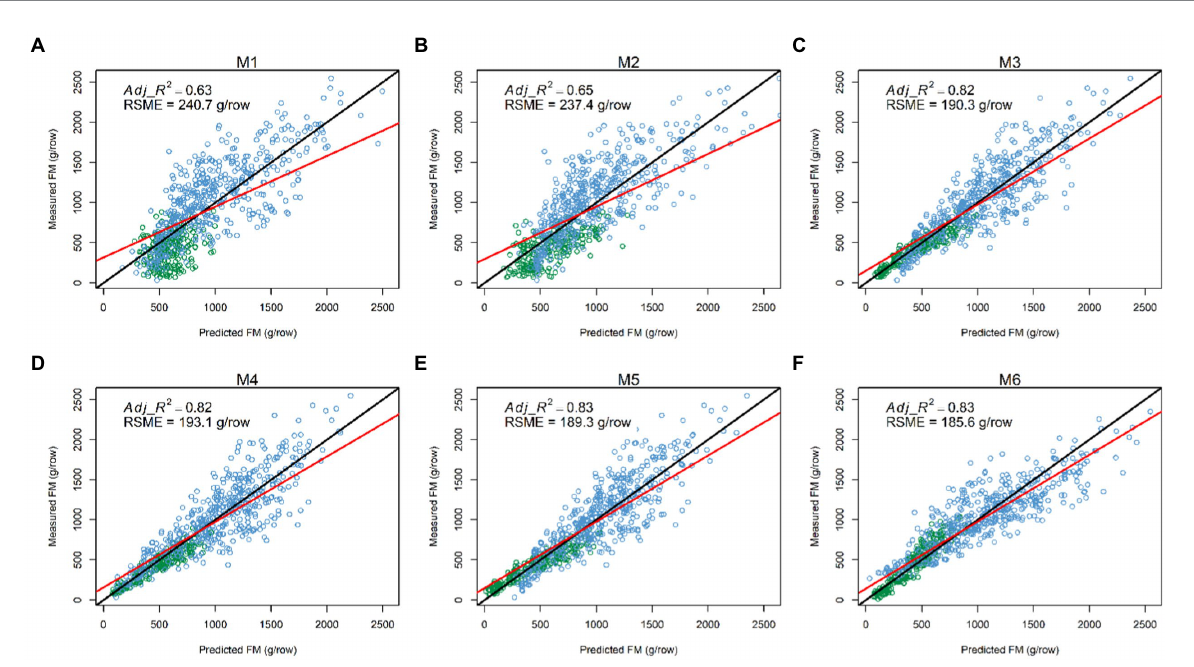
FIGURE 6 Comparisons between measured and predicted fresh biomass (FM) at the row level (N = 720) in the combined dataset from six models: (A) M1: ~